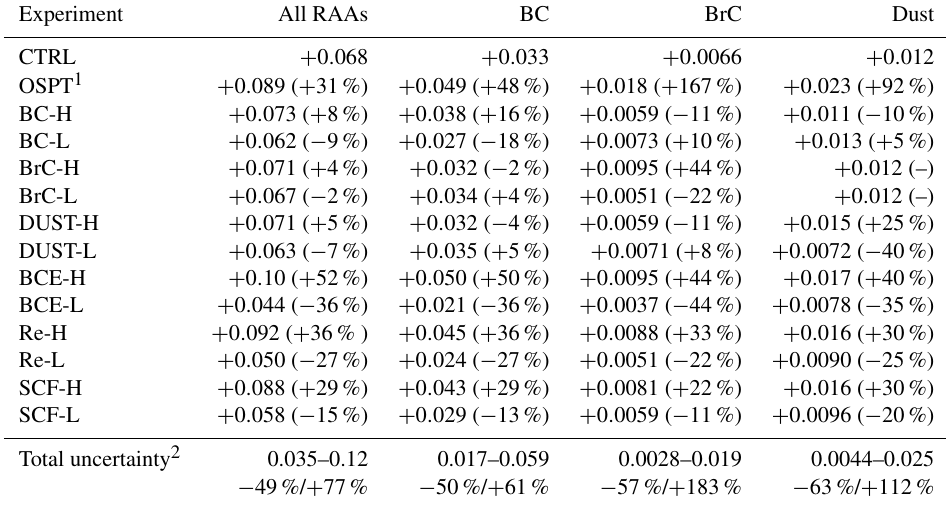
Table 3. Global all-sky annual mean surface snow RF (Wm − 2 ) of total RAAs, BC, BrC, and mineral dust calculated in the experiments discussed in Sect. 2.4 (see also Table 1). The percentages represent the deviations from the CTRL run. Experiment All RAAs BC